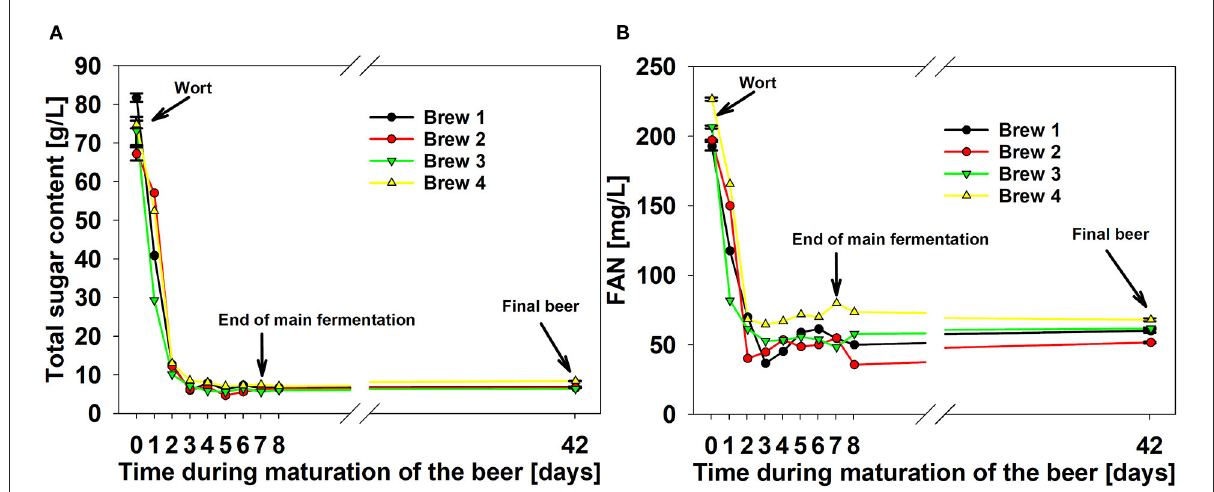
FIGURE2 Development of main yeast substrates during fermentation until final beer. Total sugar content (A) and free amino nitrogen (B) . Mean and standard deviation shown for wort and final beer ( n = 3).